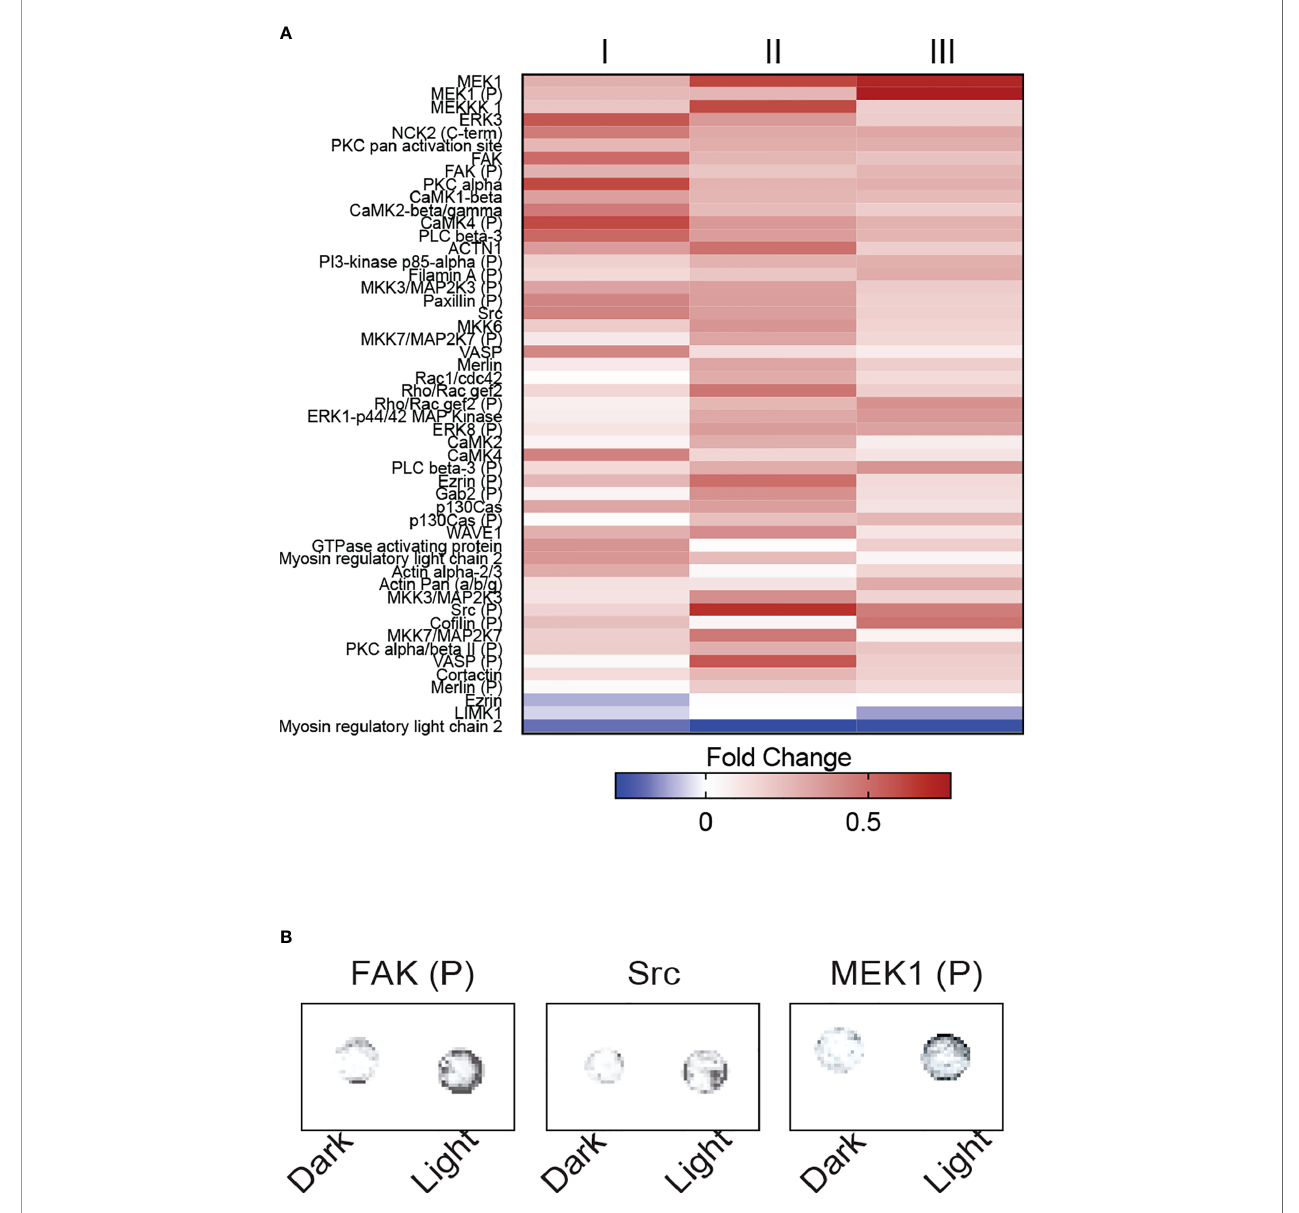
FIGURE 6 | OptoMito-On activation increases cytoskeletal rearrangements. (A) Heat map showing the fold change in protein expression from the dark to light conditions of the Full Moon BioSystems Cytoskeleton Phospho antibody array (n = 3). (B) Representative antibody array images of a few proteins of interest, FAK, Src, and